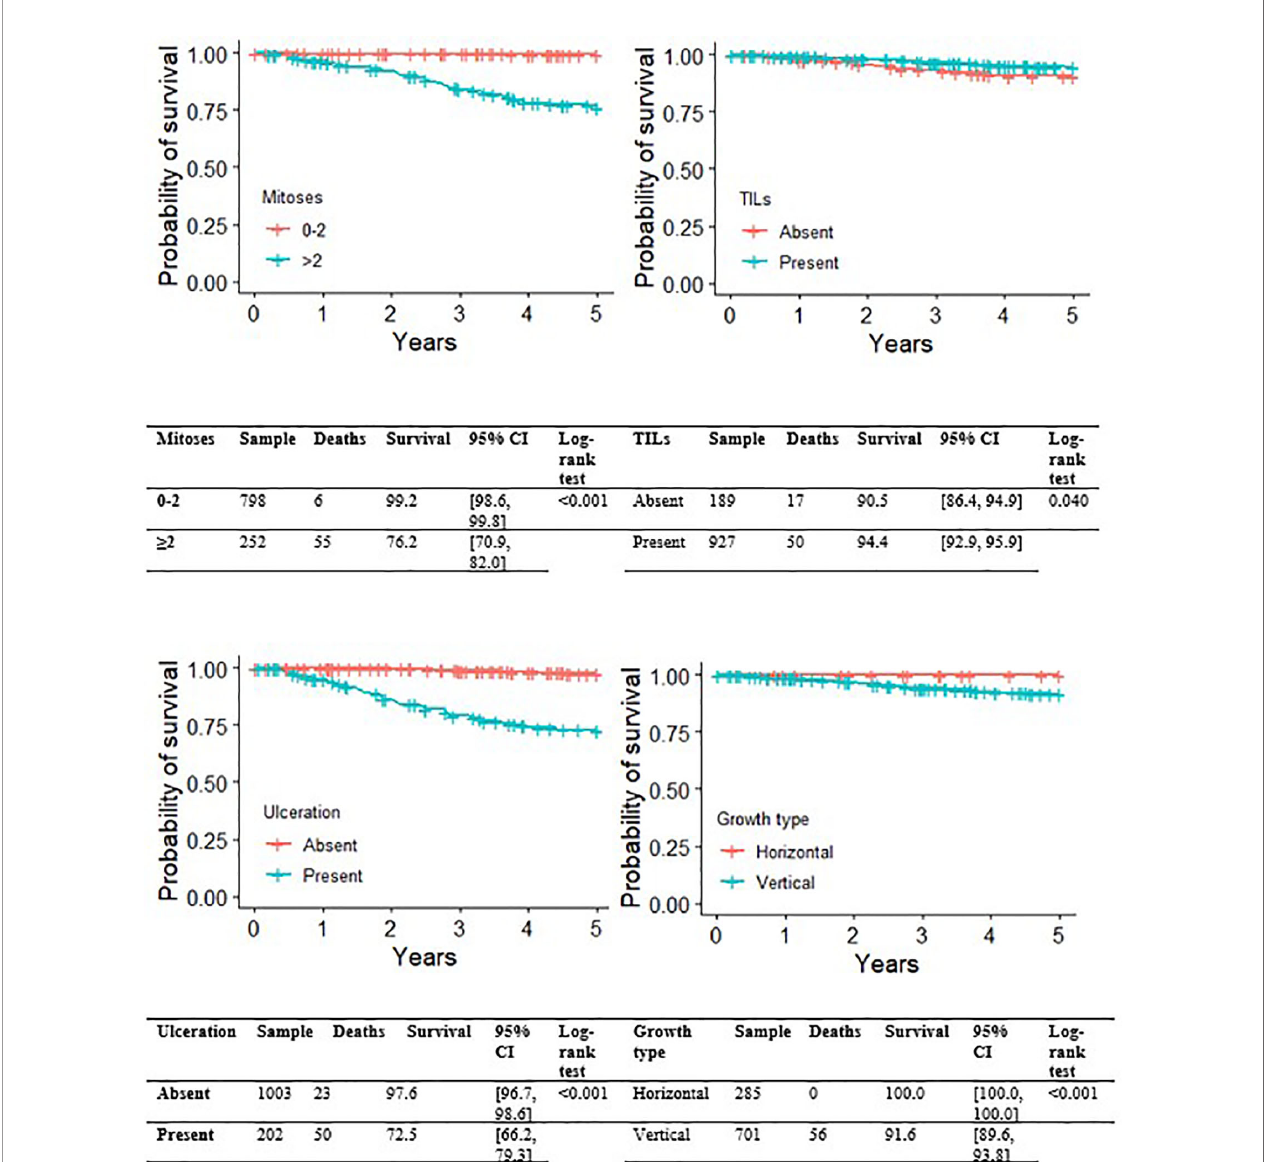
FIGURE 2 | Kaplan-Meier curves for melanoma-speci fi c survival by presence of ulceration, growth phase, presence of